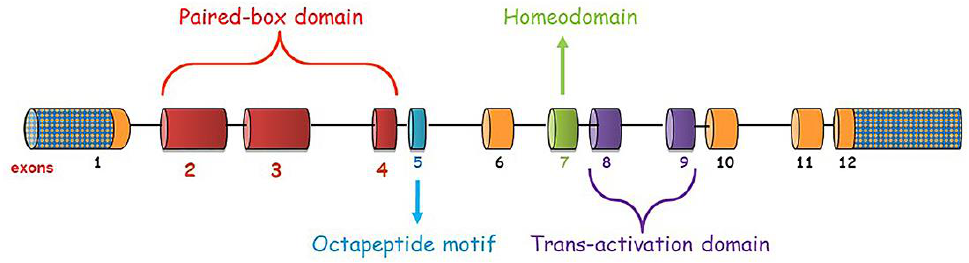
Figure 1. PAX2 gene structure (exon–intron dimensions are not in scale measure). UTR regions are checkered.